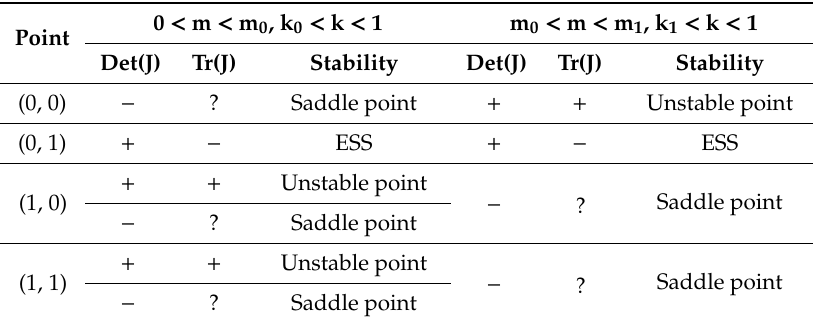
Table 5. Stability analysis of the points in case (2).